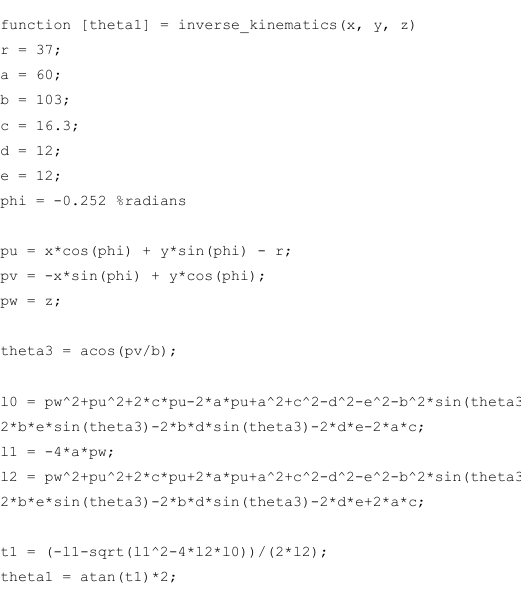
Code Sample 1: Inverse Kinematics (MATLAB) Figure 5. Inverse Kinematics